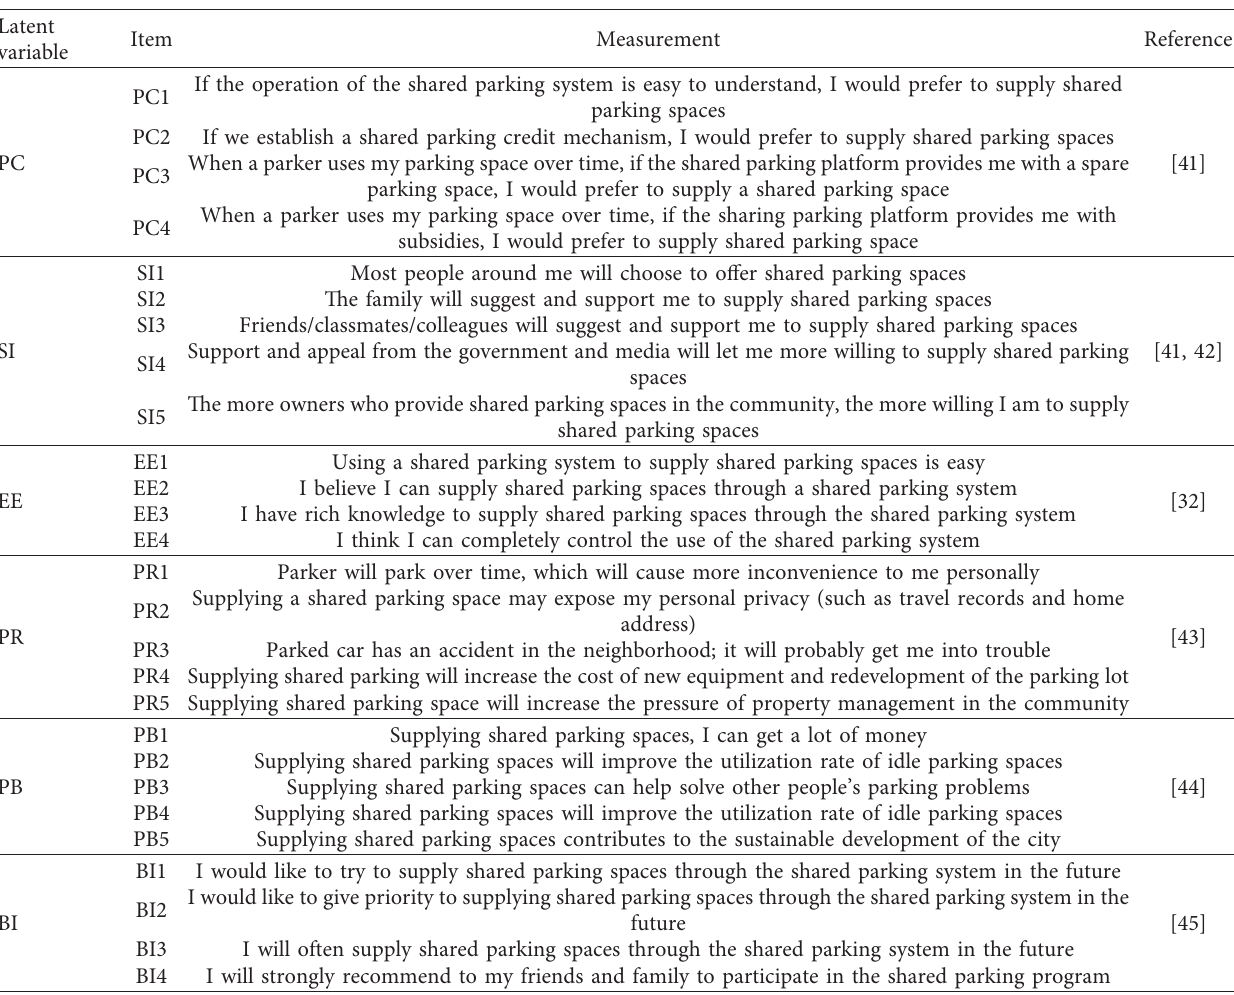
Table 3: Descriptive statistics of observed